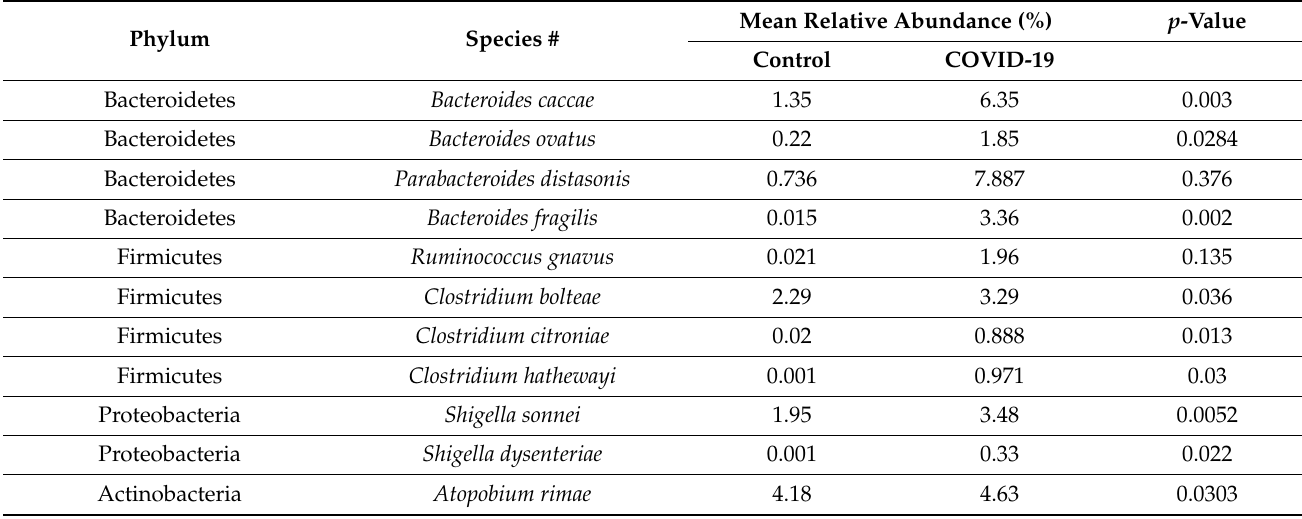
Table 4. Bacterial groups positively associated with severely infected COVID-19 patients.